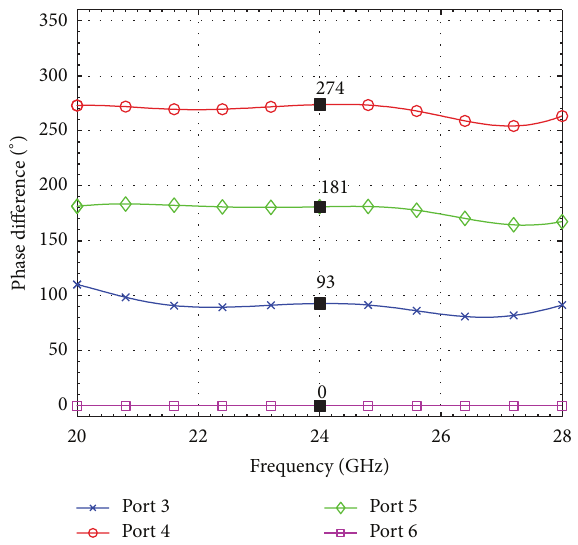
Figure11:Simulatednormalizedphasedifferenceattheoutputports of the Six-port network (reference port 6 is set to 0 ∘